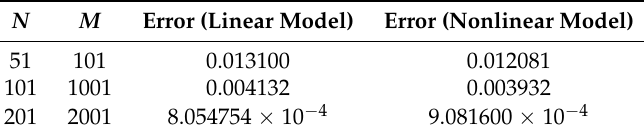
Table 3. (cid:96) 2 -error for the linear and nonlinear